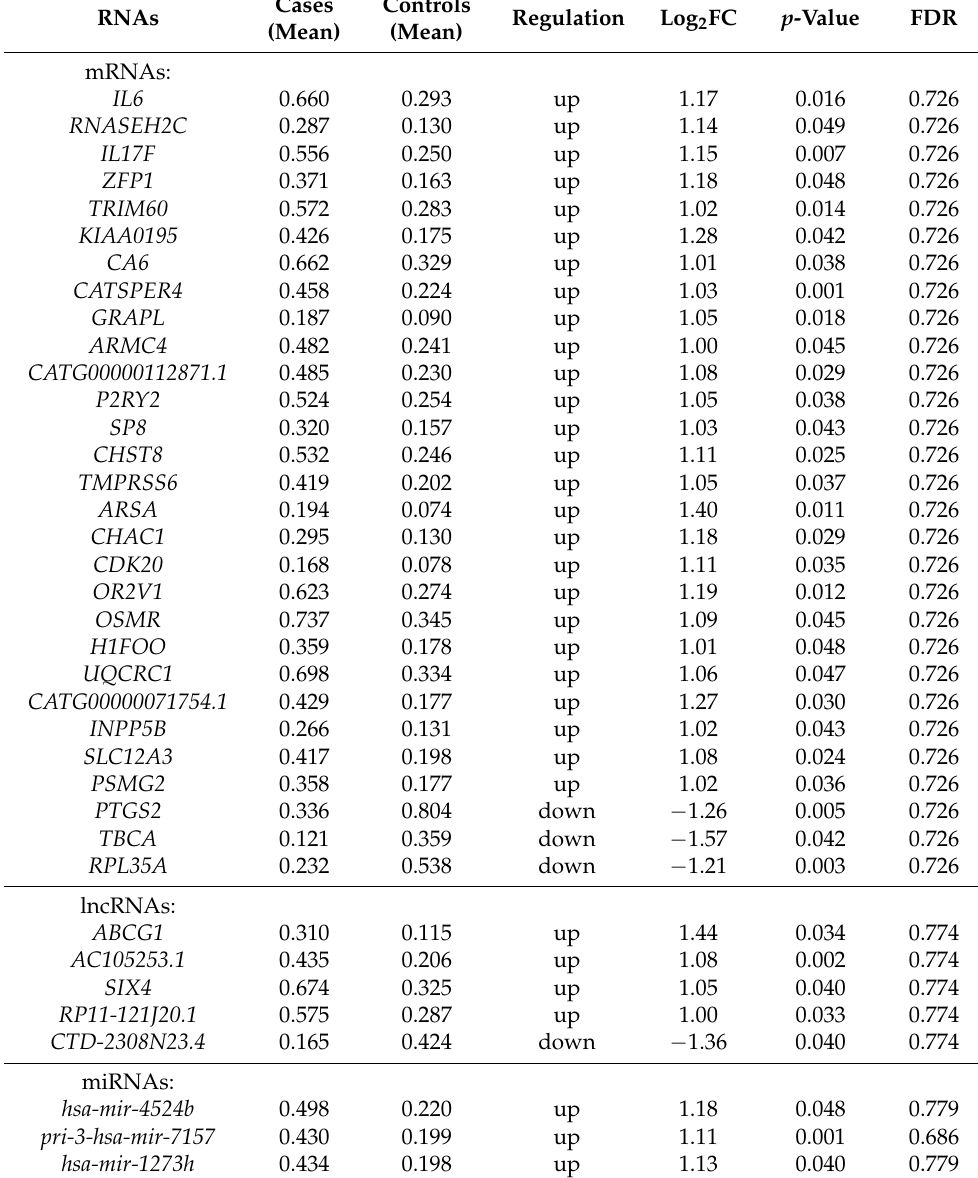
Table 2. Differentially methylated mRNAs, lncRNAs, and miRNAs in postmortem NAc of AUD subject.